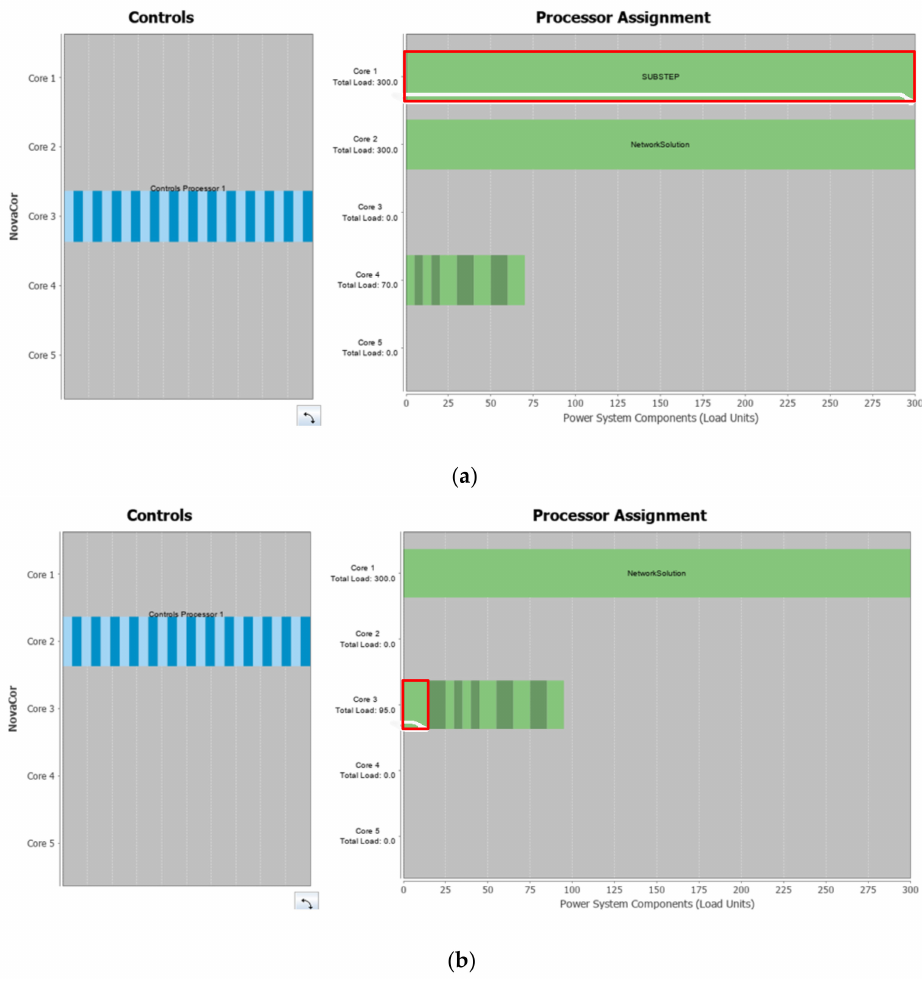
Figure 17. Processor assignment of the RTDS for the case study: ( a ) processor assignment when the Scott Connection is configured using the Substep model; ( b ) processor assignment using the proposed